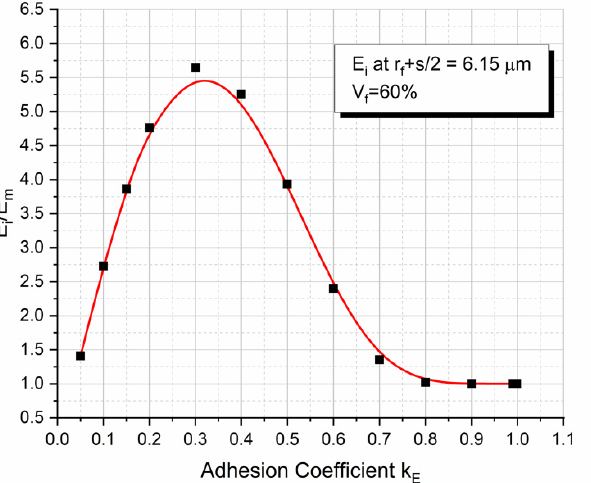
Figure 7. Normalized interphase-to-matrix modulus at the half-distance between two adjacent E-glass fibers for a 60% volume fraction for different adhesive coefficients k E